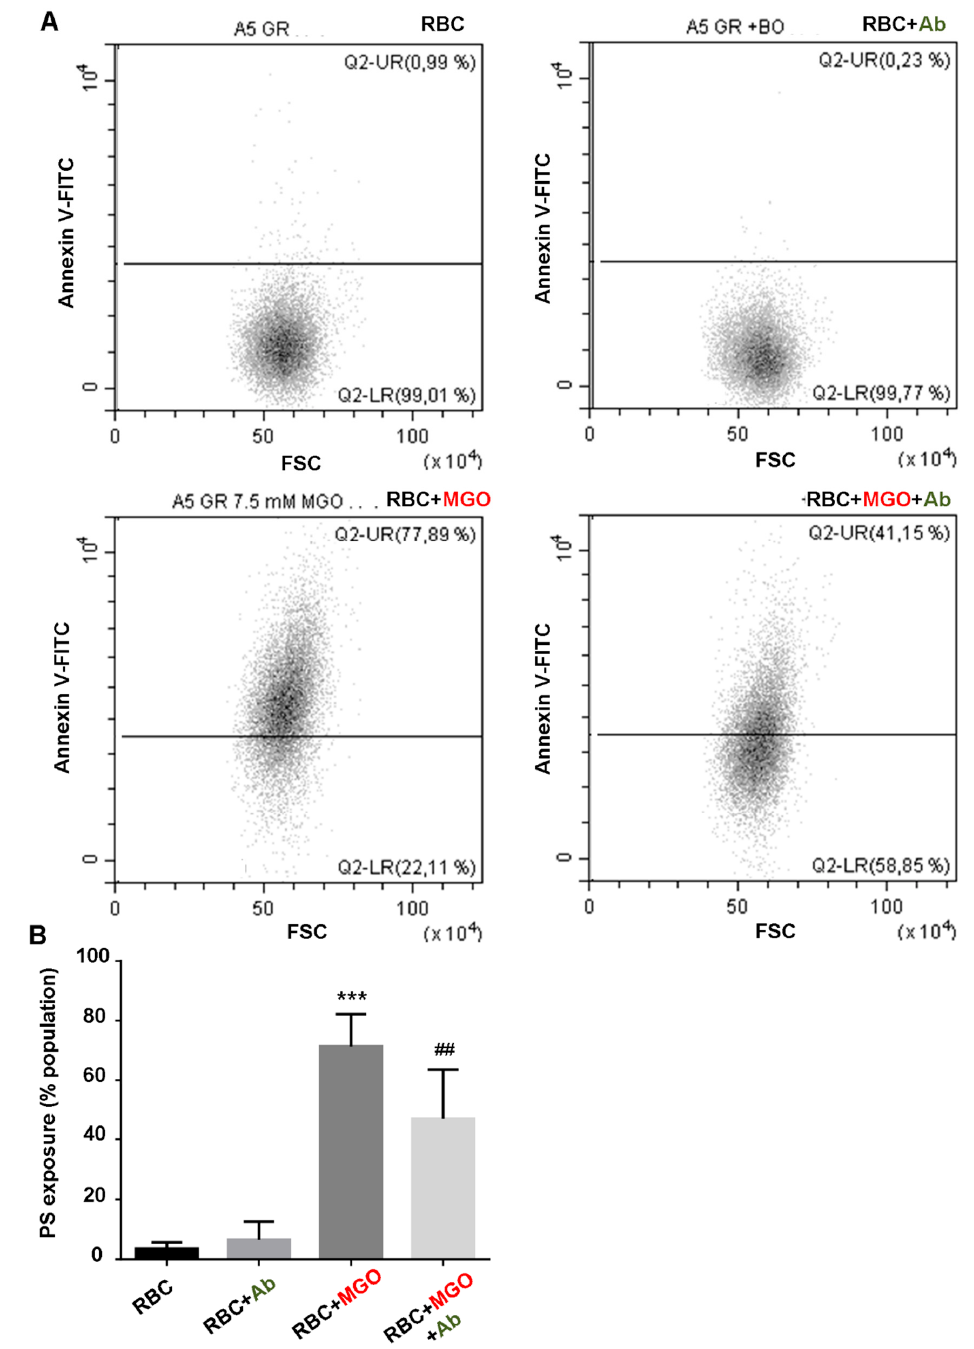
Figure 4. Antirhea borbonica protects erythrocytes from MGO-induced eryptosis. Phosphatidylserine exposure (PS) was investigated by flow cytometry by using annexin V-FITC fluorescent probes. ( A ) Typical representative FACS dot plots after annexin V staining of RBC; RBC + Ab ; RBC + MGO and RBC + MGO + Ab erythrocytes. ( B ) Average percentage of PS exposure compared with RBC. Data are mean ± SEM of six independent experiments. *Effect of MGO (vs. RBC), *** p < 0.001. # Effect of Ab (vs. RBC + MGO), ## p < 0.01.